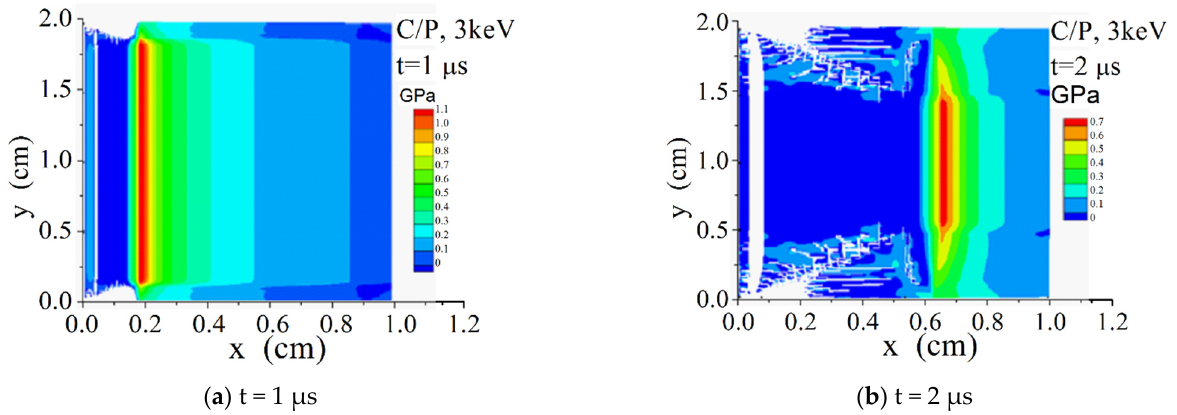
Figure 10. σxx (GPa) contours of C/P under radiation of X-ray with 3 keV blackbody spectrum. ( a ) t = 1 us; ( b ) t = 2 us.